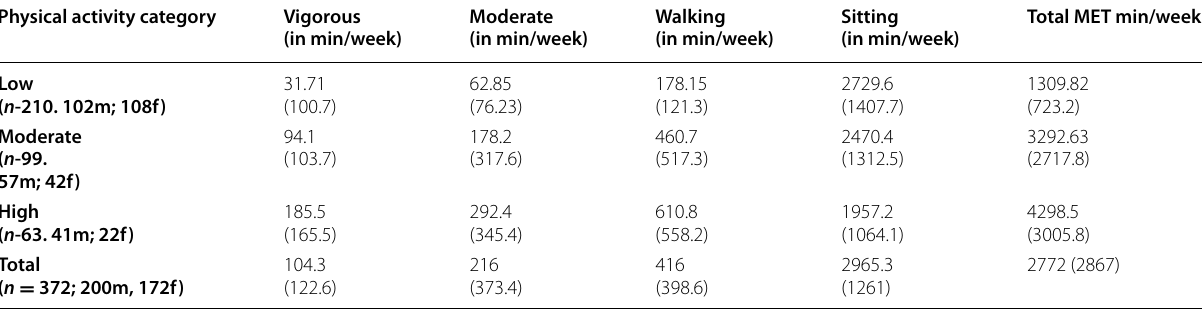
Table 4 Correlation between demographic characteristics and physical activity categories among participants ( n